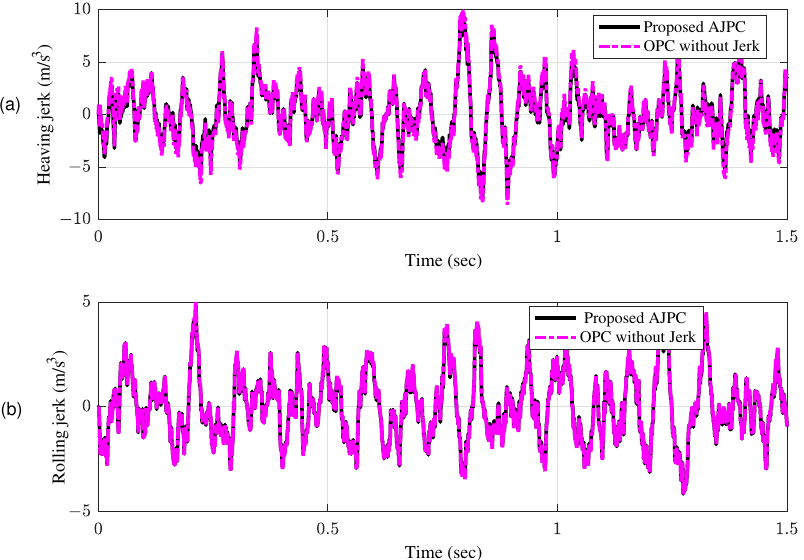
Figure 14. Time domain response of vehicle body jerk to an asphal road using proposed AJPC strategy and OPC strategy without jerk; ( a ) heaving jerk ( b ) rolling